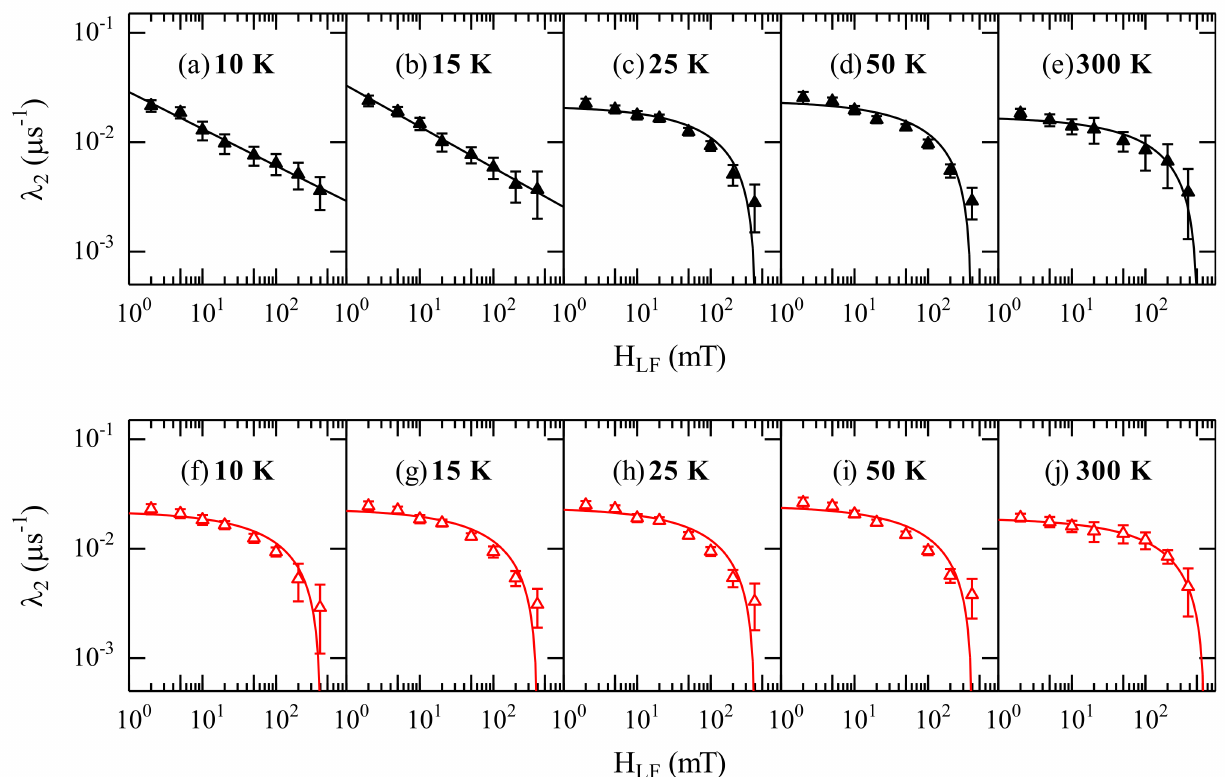
Figure 5. The longitudinal field dependence H LF of the relaxation rate λ 2 of the regio-regular P3HT–ZnO nanoparticles without light irradiation at temperatures of ( a ) 10 K, ( b ) 15 K, ( c ) 25 K, ( d ) 50 K, and ( e ) 300 K and with light irradiation at temperatures of ( f ) 10 K, ( g ) 15 K, ( h ) 25 K, ( i ) 50 K, and ( j ) 300 K.